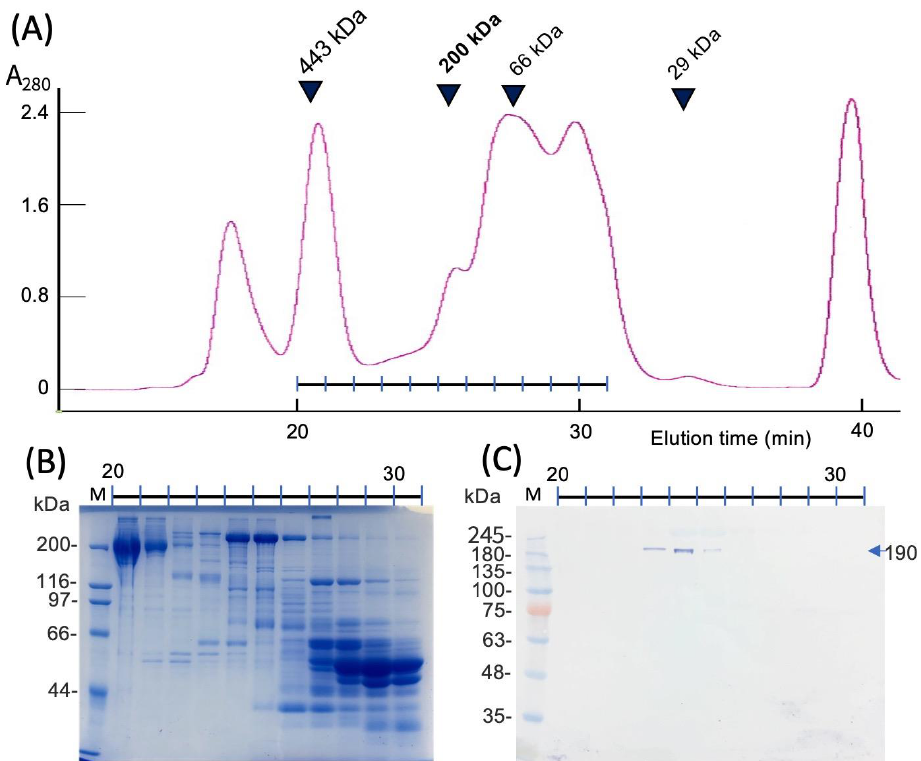
Figure 2. Specificity of anti-peptide antibody towards α-chain of carp C4-1 isotype. ( A ) Elution profile carp serum proteins eluted from a Superdex 200 Increase column (1 × 30 cm) equilibrated with PBS. Positions of appearance of marker proteins (apoferritin, 440 kDa; β-amylase, 200 kDa; bovine serum albumin, 66 kDa; carbonic anhydrase, 29 kDa) are shown by triangles. Eleven fractions (0.5 mL each) collected from 20 min to 31 min, shown by a horizontal bar with ticks, were subjected to SDS-PAGE on 10% gel ( B ) and Western blotting ( C ). ( B ) Coomassie-Blue-stained SDS-gels of the fractions run under non-reducing conditions. ( C ) Western blot of the same eleven fractions stained with anti-C4-1α (1/1000 dil.), peroxidase-conjugated secondary antibody, and TMB substrate. Lanes M show marker proteins in ( B , C ), and molecular masses of the markers are shown on the left of each panel.